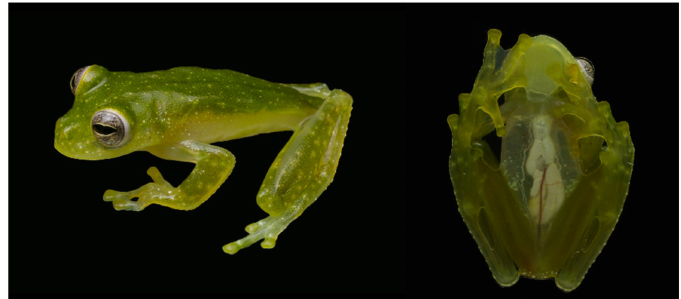
Figure 215. Teratohyla pulverata in life. Individual (QCAZ 32224) from Silanche, Pichincha province. Photos by Luis A.